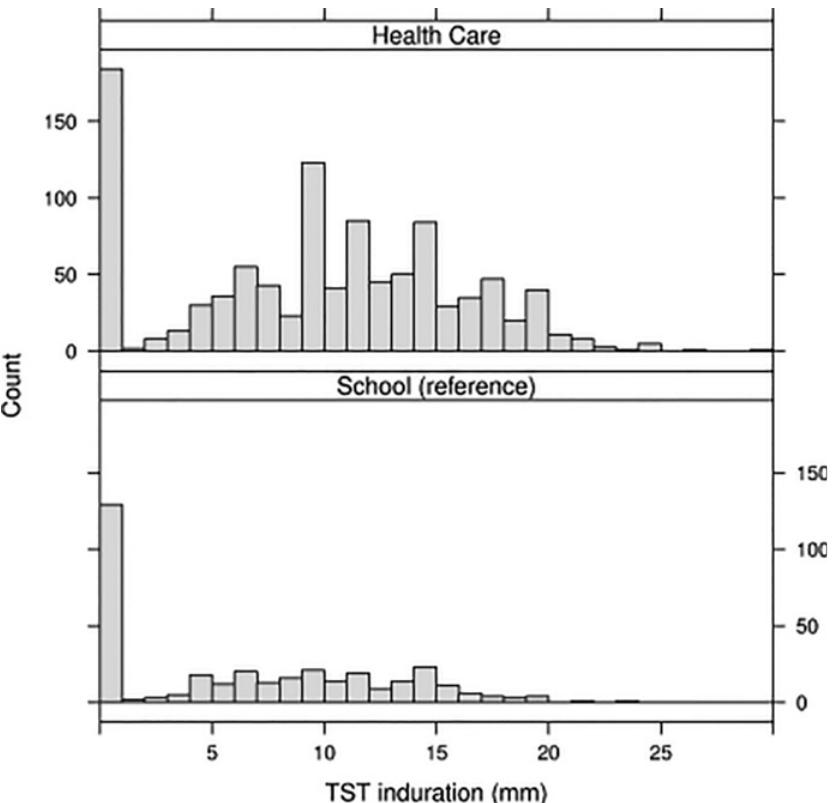
Fig 2. Distributions of TST indurations (mm) for health-care workers and school workers from ten health-care catchment areas in Kigali, Rwanda. Thirty (2.6%) and 10 (2.6%) HCWs and SWs, respectively, either self-reported or tested HIV positive, and 818 (99%) HCW and 280 (98%) SW who tested HIV-negative were classified as such. doi:10.1371/journal.pone.0124485.g002 Table 1. Descriptive characteristics of 1,131 health care workers and 381 school workers from Kigali, Rwanda.